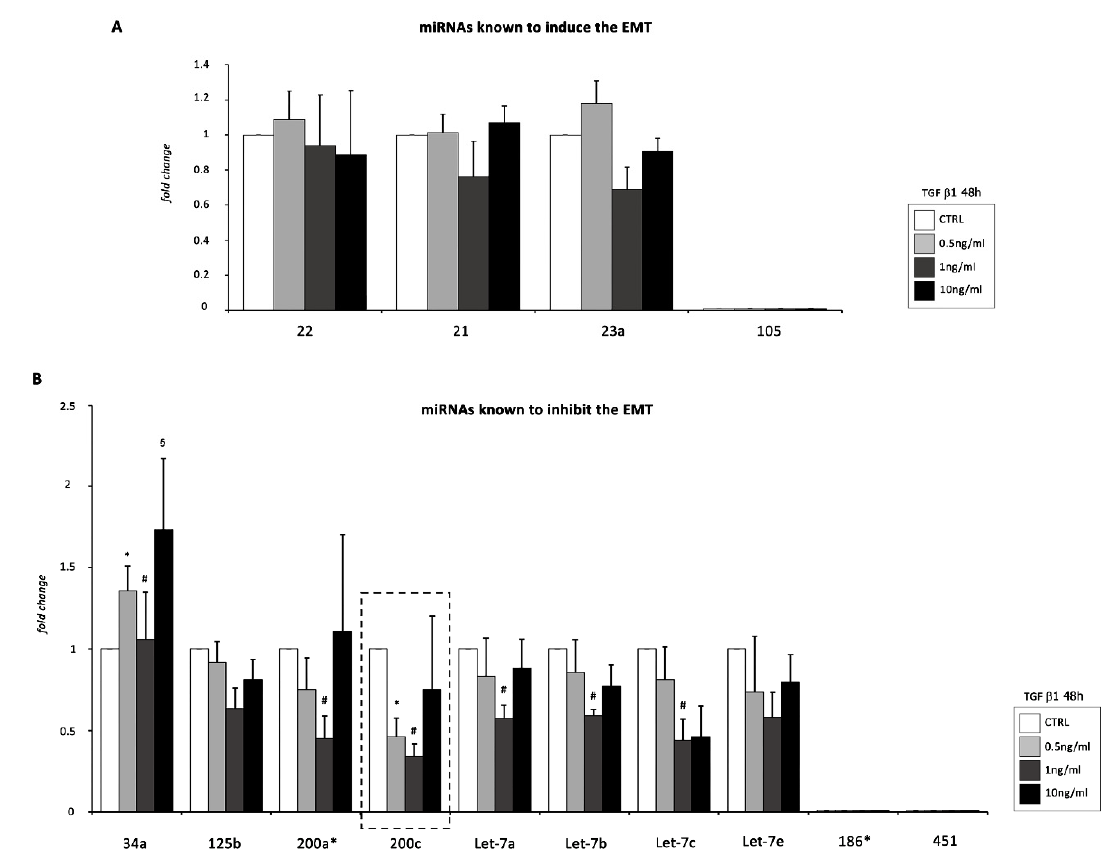
Figure 5. Screening of different miRNA implicated in TGF β 1-induced EMT of EMCs. ( A ) Panel of miRNAs that induces the EMT. ( B ) Panel of miRNAs that inhibits the EMT. The level of expresScheme 202. (endogenous control) and represent means ± SEM of three separate experiments, each repeated in triplicate. *, p < 0.05 for 0. 5 ng/mL of TGF β 1; #, p < 0.05 for 1 ng/mL of TGF β 1; §, p < 0.05 for 10 ng/mL of TGF β 1 vs. control conditions (CTRL).